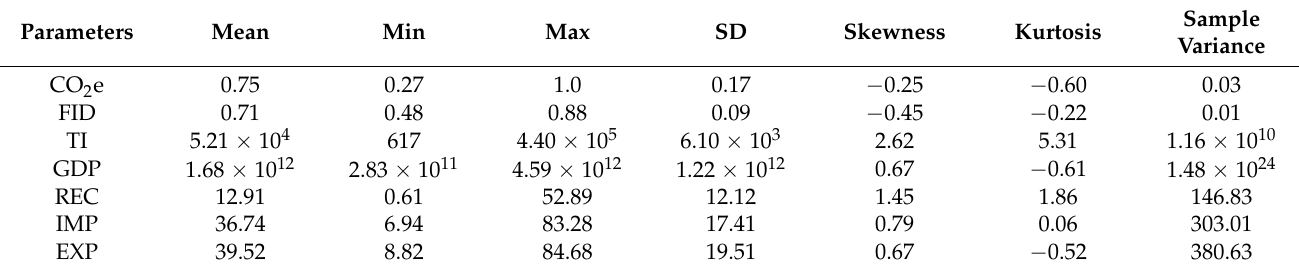
Table 1. Represents the parameters under investigation and their sources. Parameters Abbreviation Measurement Source Carbon-Dioxide CO 2 e Metric ton World Bank Emissions FID is constructed from financial Financial Institutional FID institutional depth, access, and Deepening efficiency Patent applications, residents, and Technology TI Innovations GDP Products